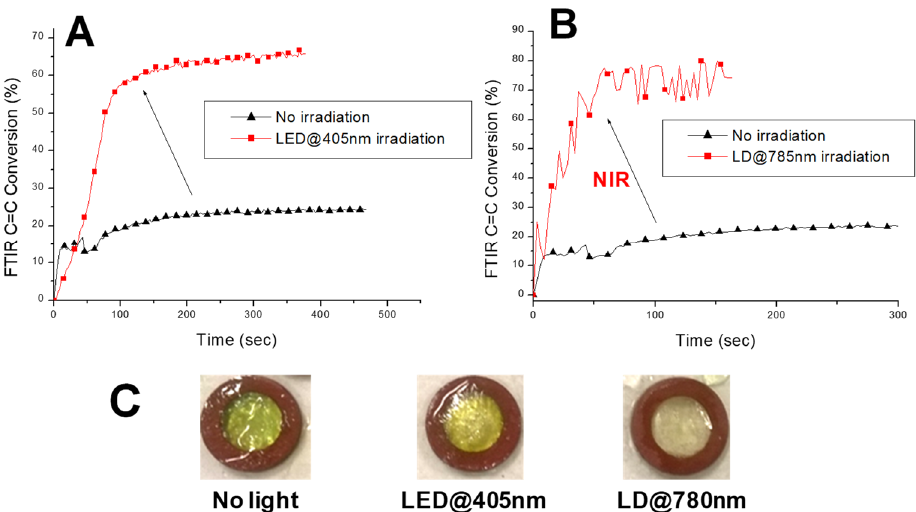
Figure 37. Polymerization profiles obtained during the FRP of the (1,4-BDMA/HPMA/UDMA) blend under air with the two-component Cu-42 /2-dppba (1%/1.5% w / w ) systems with Cu-42 prepared (1) by mechanosynthesis (2) in solution (3) starting from Cu(acac) 2 and 2-dppba. Inset: pictures of the